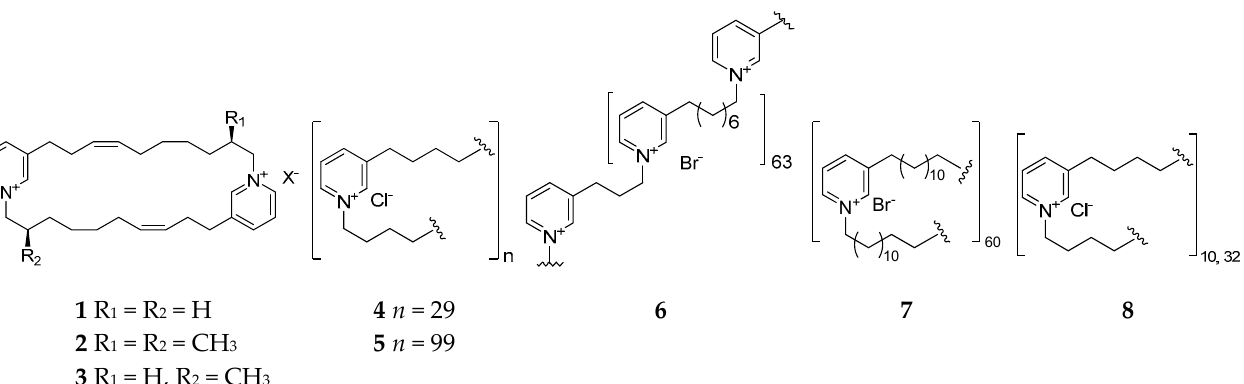
Figure 1. 3-Alkylpyridiniums 1 – 5 from the subgenus Reniera and their derivatives 6 – 8.